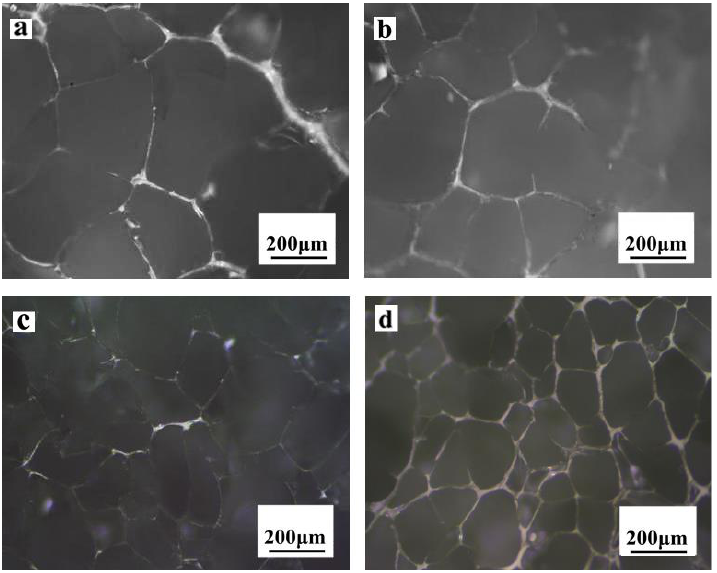
Figure 3. The effect of ( a ) 3%, ( b ) 5%, ( c ) 8% and ( d ) 10% concentration of gelatin methacrylamide on the pore size. the pore